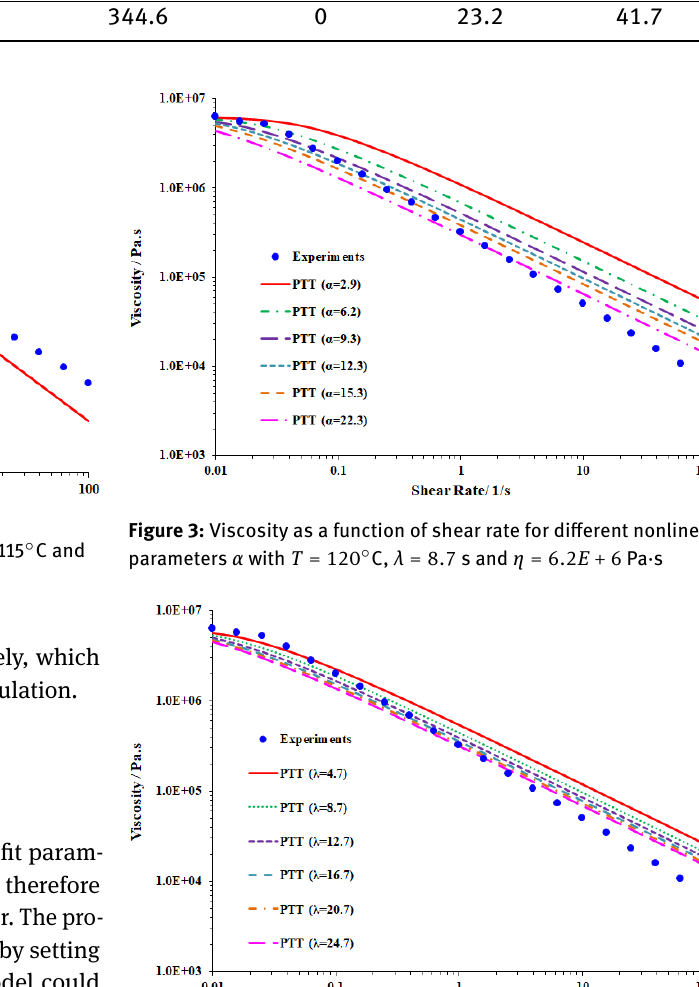
Figure 4: Viscosity as a function of shear rate for different relaxation times λ with T = 120 ∘ C, α = 12.3 and η = 6.2 E + 6 Pa ·